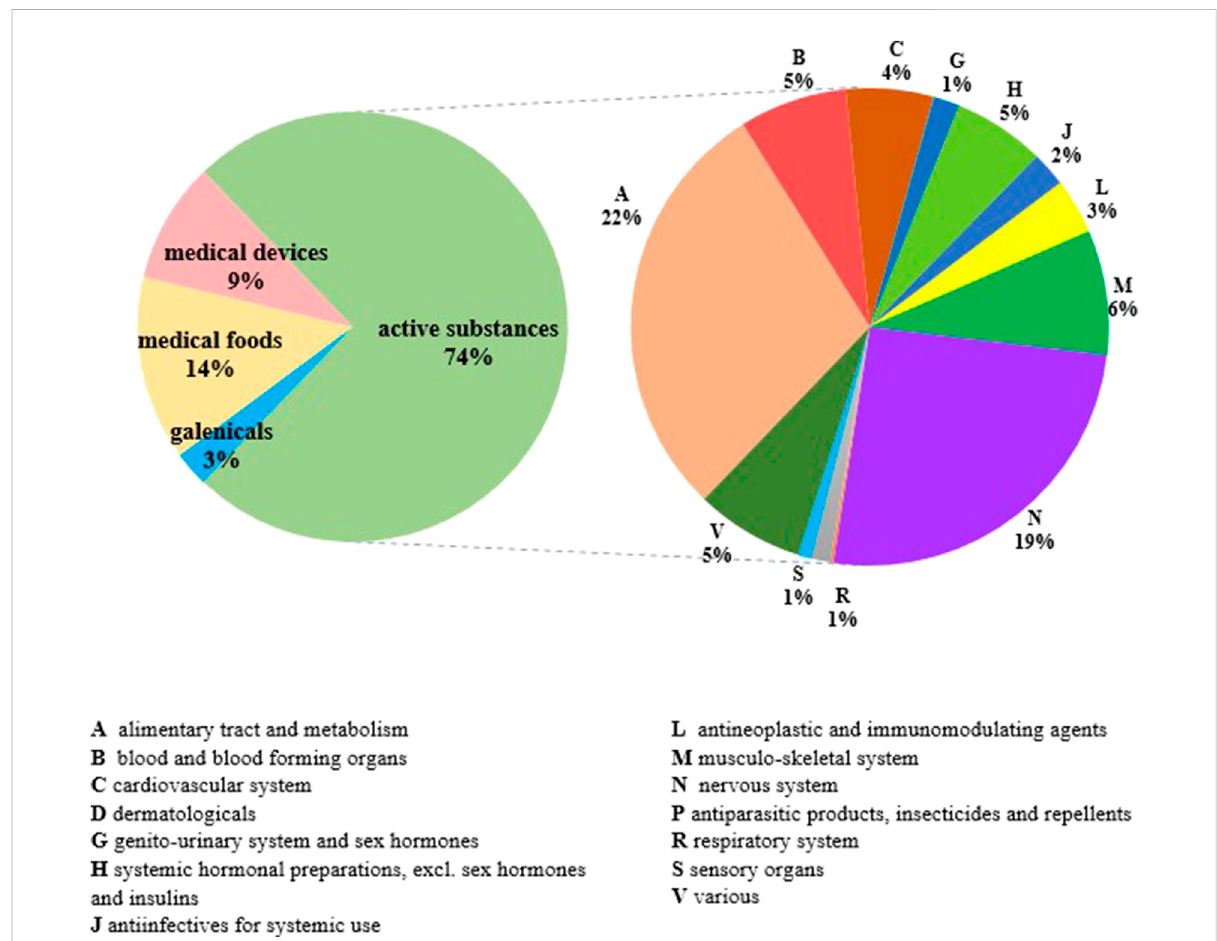
FIGURE 6 Distribution of medication plans including fi ve or more cotreatments per treatment typology and per active substances ATC class ( n =